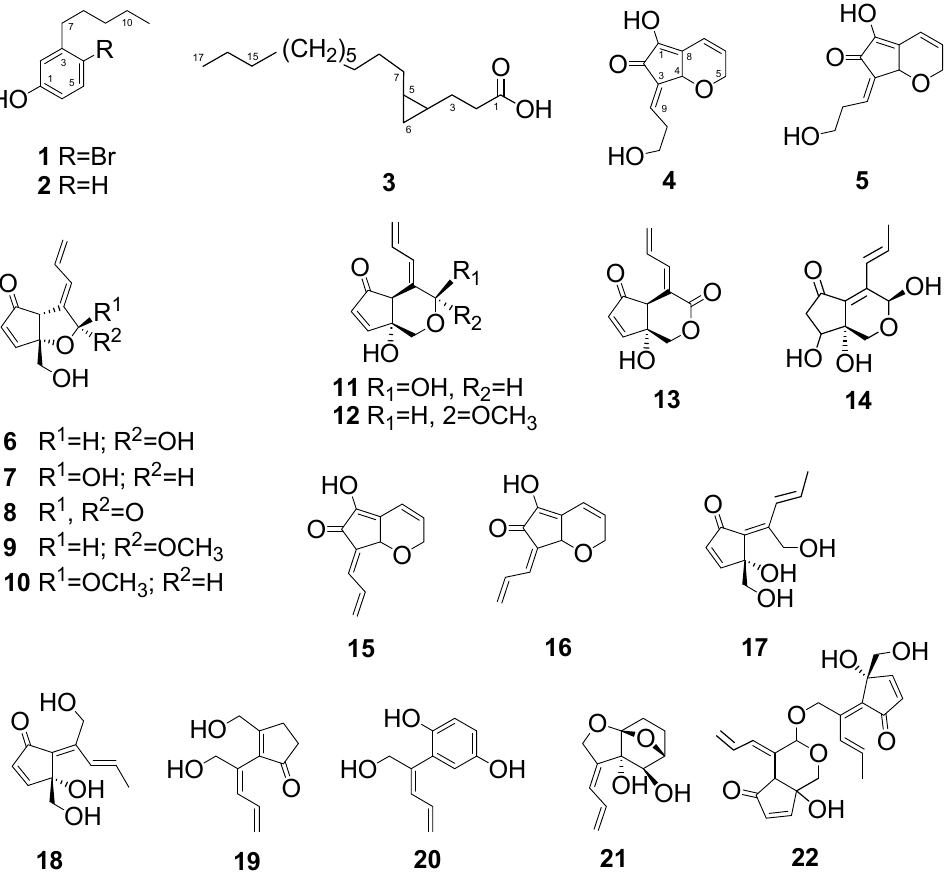
Figure 1. C compounds and a cyclopropane fatty acid from marine 11